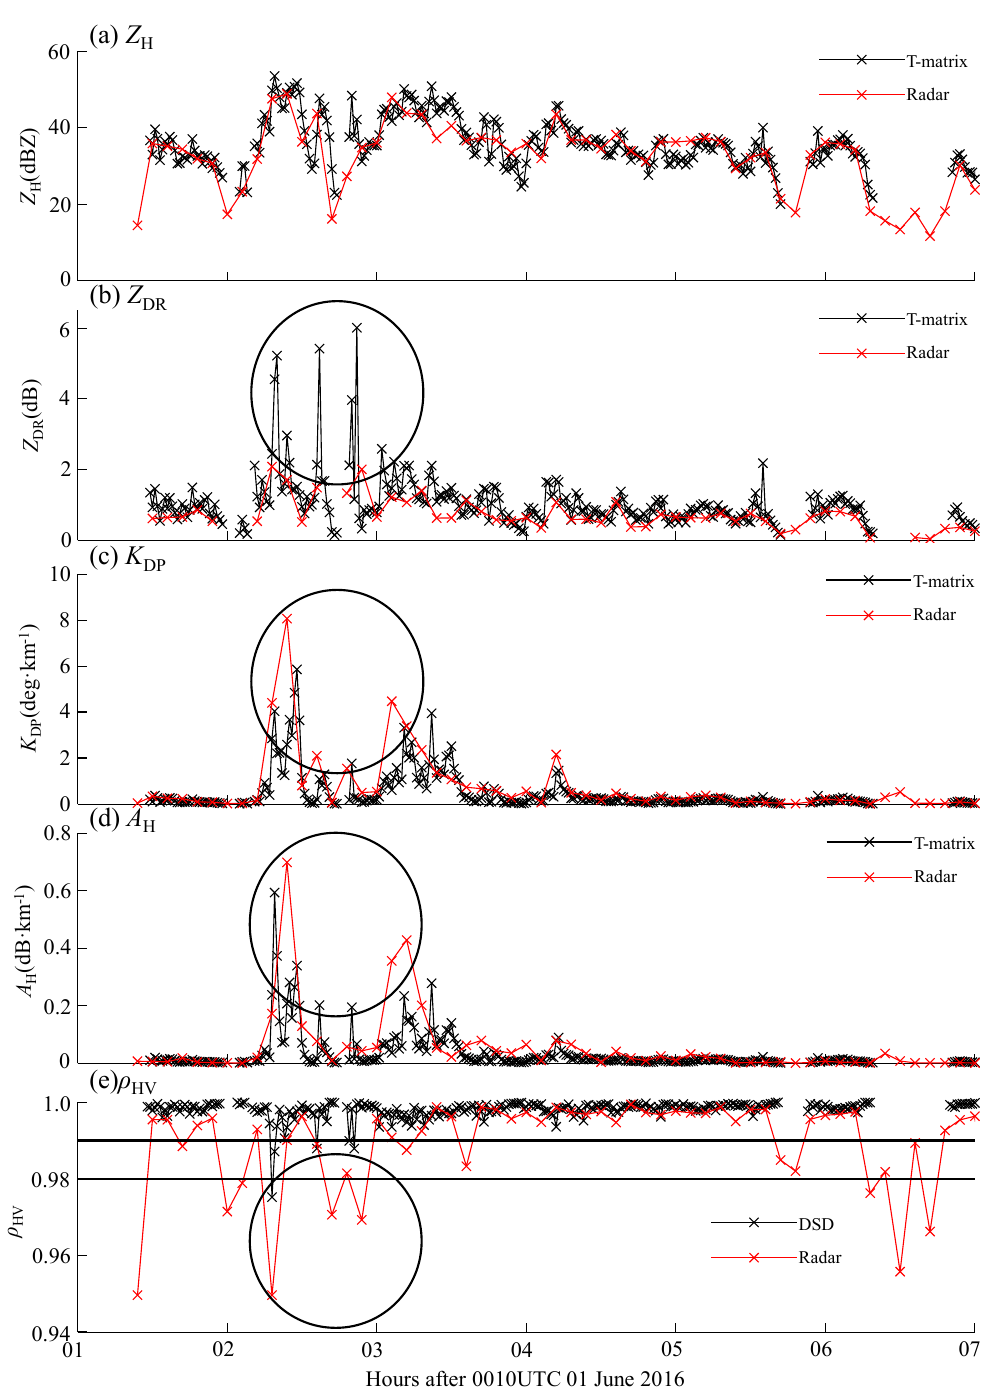
Figure 12. T-matrix-derived radar variables and CPOL radar measurements at JD station at 0100–0700 UTC on 1 June 2016: ( a ) Z H , ( b ) Z DR , ( c ) K DP , ( d ) A H , and ( e ) ρ HV . The ellipses on (b–e) indicate larger radar-observed K DP and A H values but smaller Z DR and ρ HV values than T-matrix-derived ones.